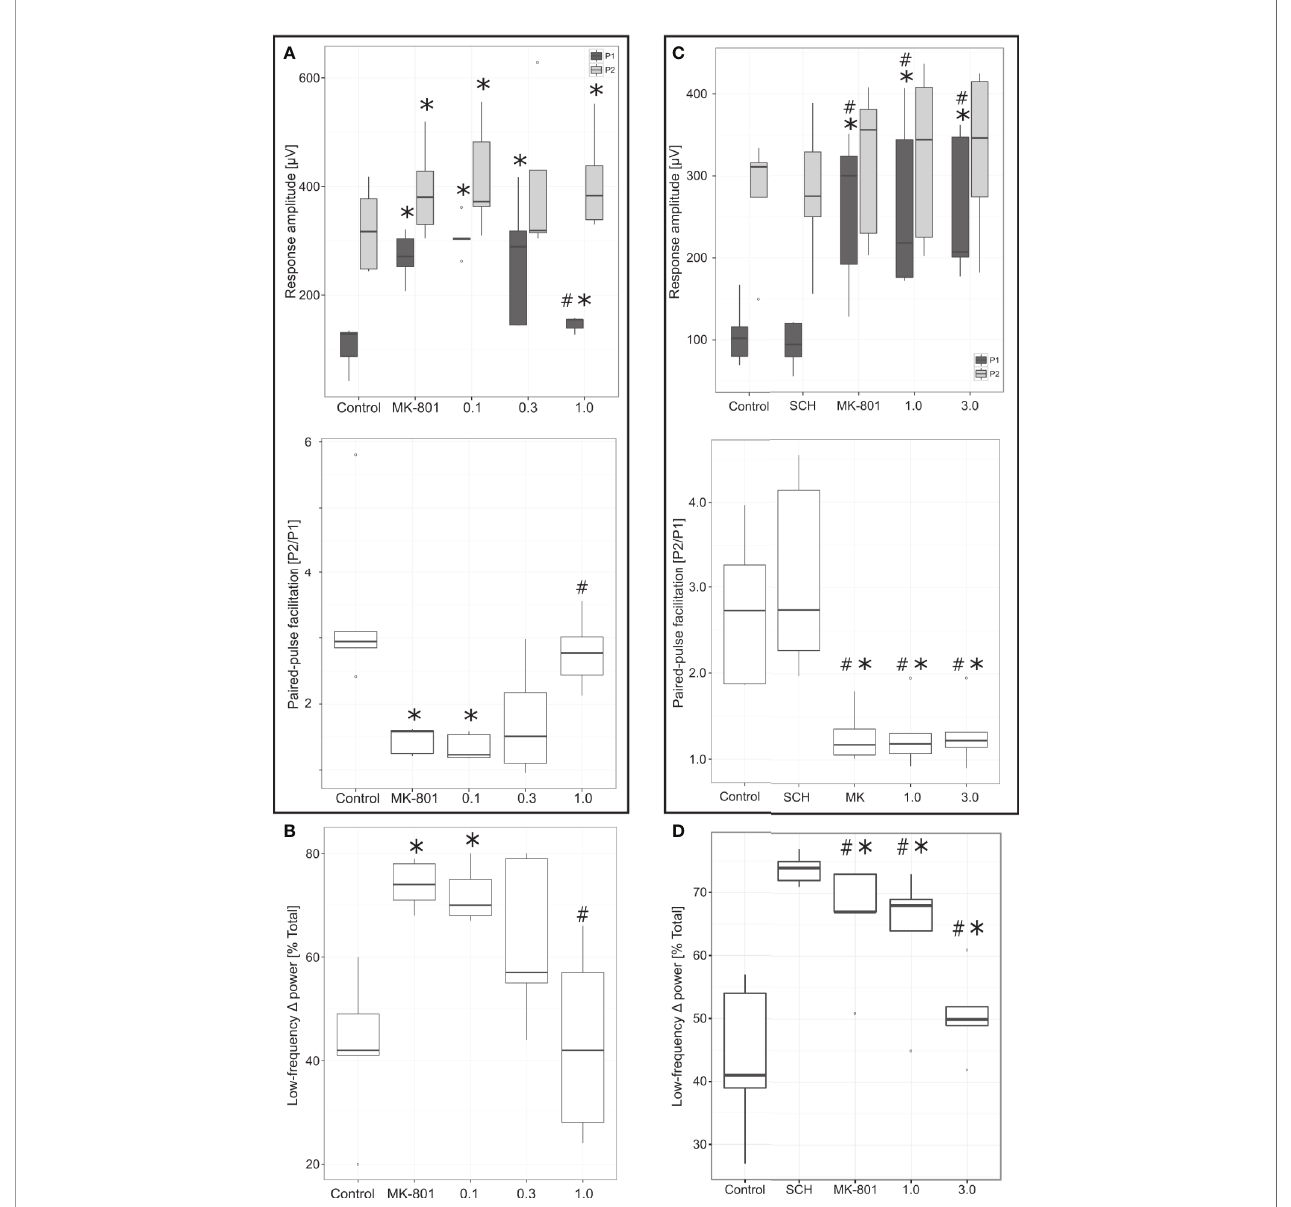
FIGURE 6 | Effects of PF-6142 on NMDA antagonist disrupted paired-pulse facilitation (PPF) and delta oscillations. (A) PF-6142 signi fi cantly reverses NMDA blockade-induced changes in PPF. PPF (calculated as P2/P1) values as a function of drug treatment. Note that PF-6142 reverses MK-801-evoked decrease of PPF with an ED 50 of 0.35 mg/kg (*: p <0.05 vs. Control, #: p <0.001 vs. MK-801; n =5). The upper and lower hinges on the boxplots show the 25 th and the 75 th percentiles, respectively, horizontal bar in the boxplot shows median value, whiskers extend to the minimum and the maximum values, “ o ” indicates data points outside of the 1.5*inter-quartile range of the hinges. (B) PF-6142 signi fi cantly reverses NMDA blockade-induced mPFC low frequency delta activity increase. Power contained in the low frequency delta (0 – 1.8 Hz) band expressed as a percentage of the total delta (0 – 4 Hz) power. Note that PF-6142 completely reverses MK-801 induced increase of low frequency delta oscillation (*: p <0.02 vs. Control; #: p <0.02 vs. MK-801; n =5). (C) Antagonism of D1Rs blocks effects of PF-6142 on PPF. Figure shows PPF values as a function of drug treatment. Note that administration of SCH-23390 alone had no effect on either the P1 or P2 components or PPF, while this pretreatment completely blocked PF-6142 effects even at high doses. (D) Antagonism of D1Rs blocks effects of PF-6142 on mPFC low frequency delta activity. Power contained in the low frequency delta (0 – 1.8 Hz) band expressed as a percentage of the total delta (0 – 4 Hz) power. Note that as with PPF SCH-23390 completely blocks effects of PF-6142 on reversing MK-801-induced changes (* p <0.05 vs. Control, # p <0.03 vs. SCH-23390; n